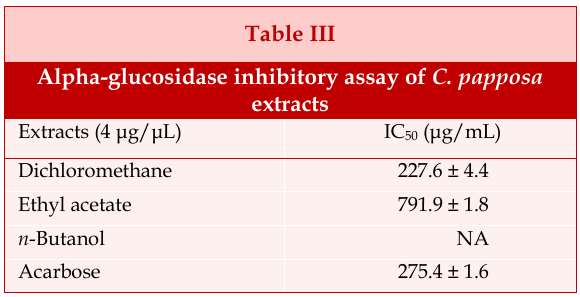
Alpha-glucosidase inhibitory assay of C.